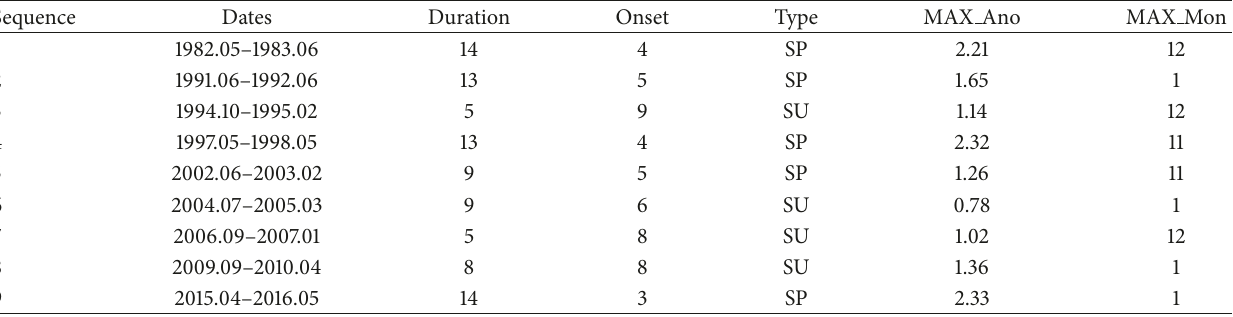
Table 1: Onset time and classification of El Ni˜no events during 1978–2016.